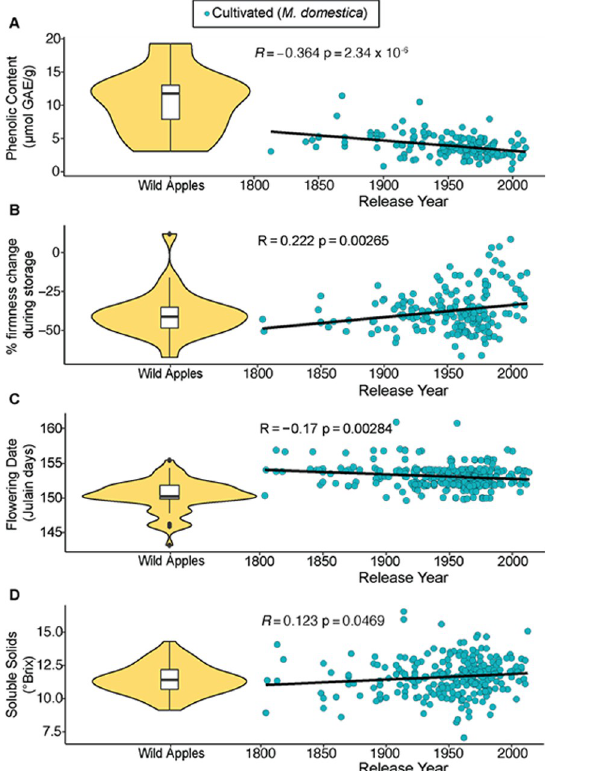
Fig 3. Phenotype values of cultivated apples as a function of their release year with a comparison to values in their wild ancestor, M . sieversii . Phenotypes include phenolic content (A), firmness change during storage (B), flowering date (C), and soluble solids (D). Values for cultivated apples are blue, and the values observed for M . sieversii are represented in yellow as a violin plot on the left side of each plot. The R and p values from a Pearson correlation between phenotypic values and release year are shown within each scatter